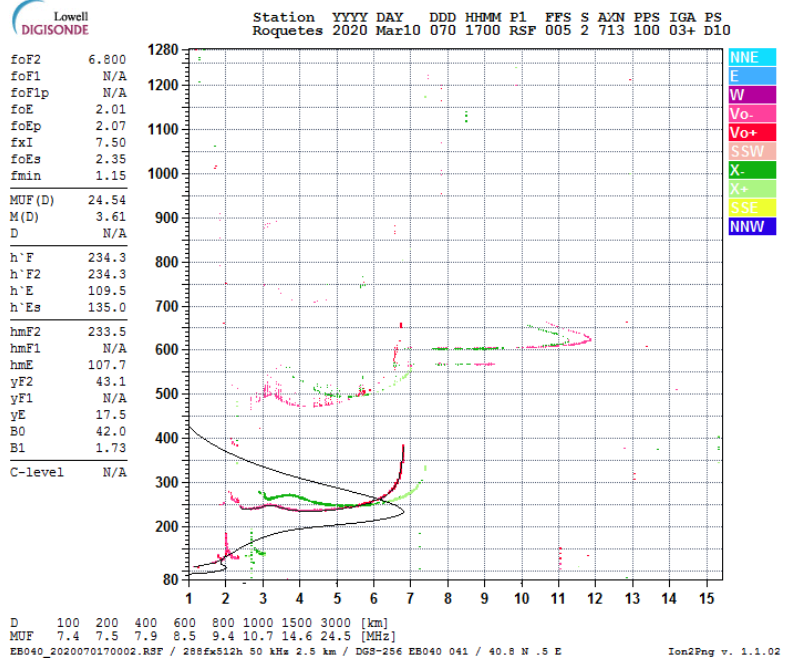
Figure 1. Ionogram of 10 March 2020 at 17 UTC recorded in Roquetes Station (Spain) offered by the Ebre Observatory. Available online at http://obsebre.es/en/checked-ionograms (accessed on 14 March